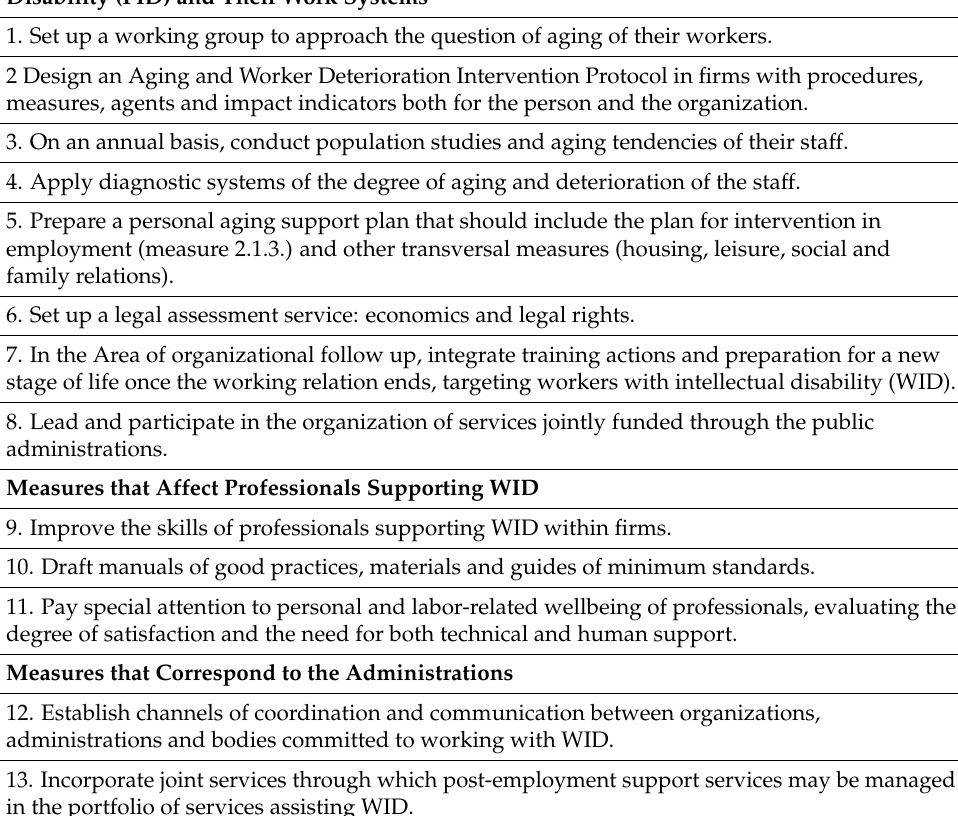
Table 3. Results for line of action